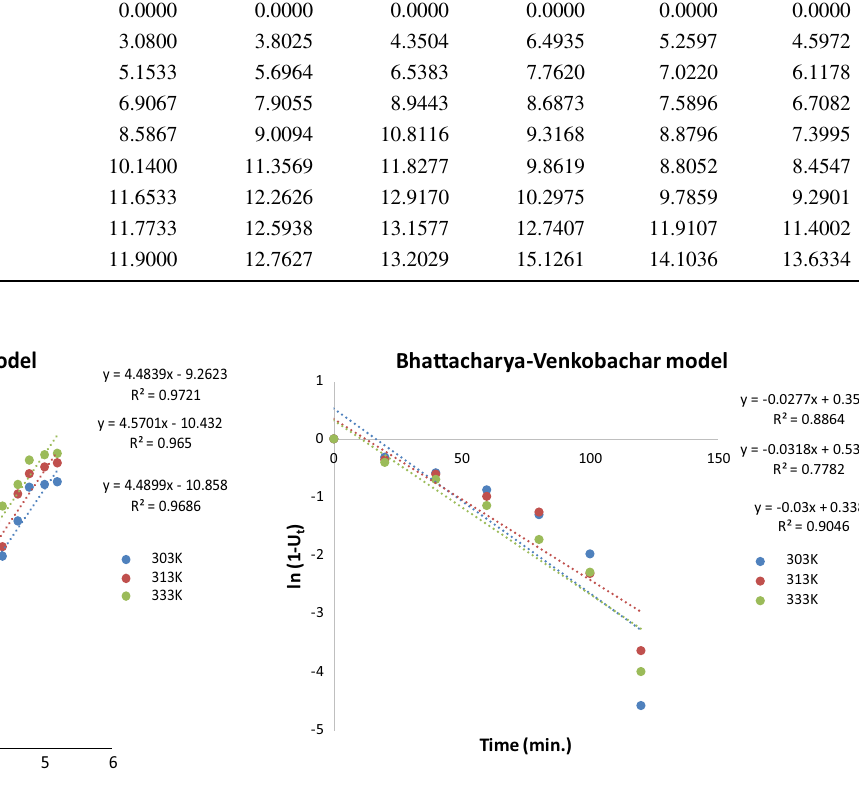
Table 6 Pseudo-second-order values for different temperature conditions